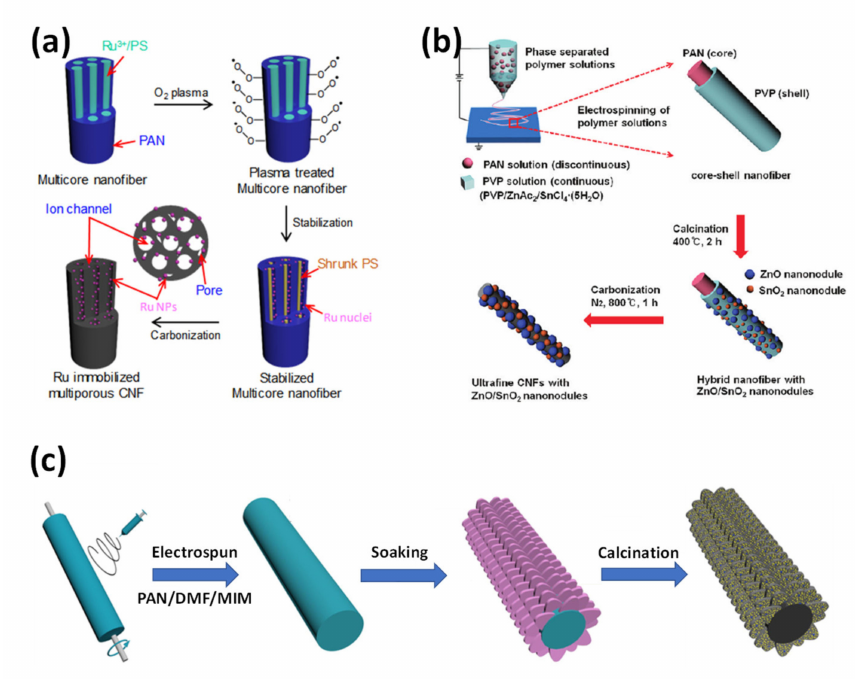
Figure 9. ( a ) Fabrication of multichannel CNFs decorated with Ru nanoparticles [76]. ( b ) Fabrication of CNFs decorated with ZnO/SnO 2 [79]. ( c ) Fabrication of CNFs decorated with MOF material